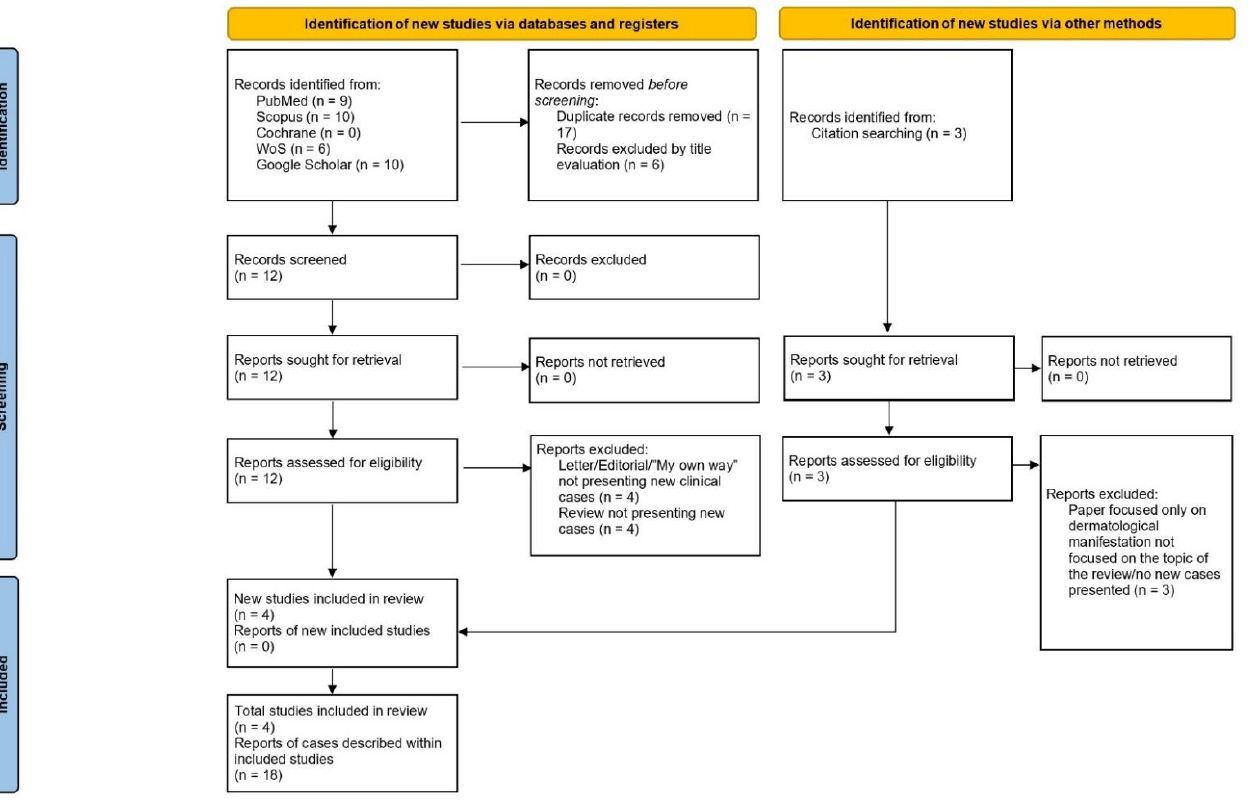
Figure 1. Study selection flow-chart.Two reviewers (R.F., N.Z.) independently performed eligibility assessment and data extraction. Disagreements between reviewers were resolved by consensus. When consensus was not reached, a senior member mediated (R.R.). A standard chart form of the obtained data was prepared to facilitate comparison of the articles.